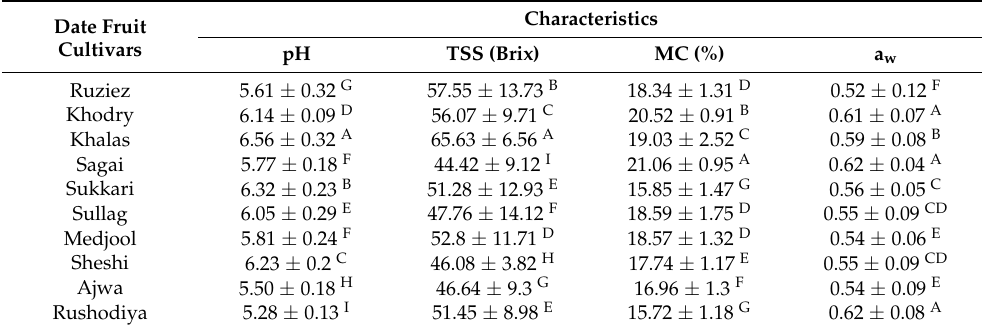
Table 1. Comparison of the mean values ± standard deviation of the pH, total soluble solids (TSS), water activity (a w ), and moisture content (MC) of the ten stored date fruits cultivars. Date Fruit